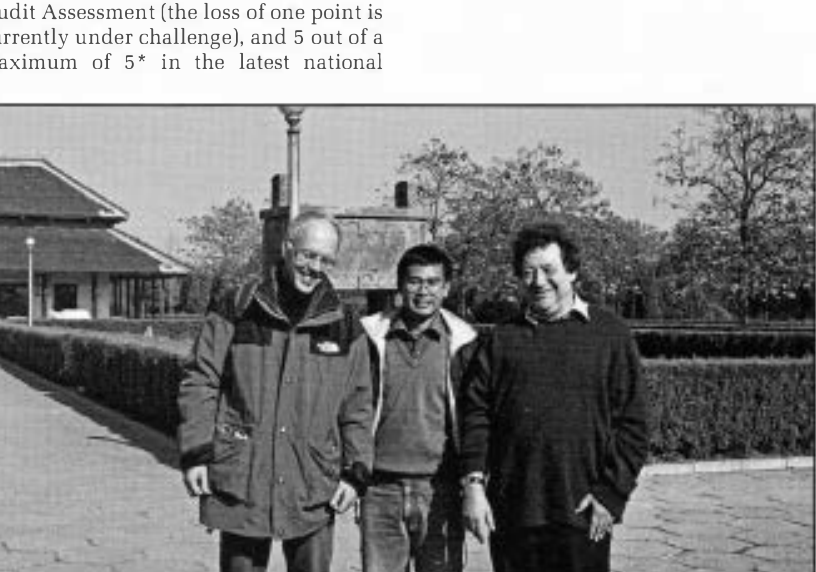
Figure 1 At Anyang Station, the excavation headquarters for the site of Anyang, north­ ern Hen an Province, China, November 2001; from left to right: Stephen Shennan, Jigen Tang (director of the current excavations at Anyang}, Peter Ucko.